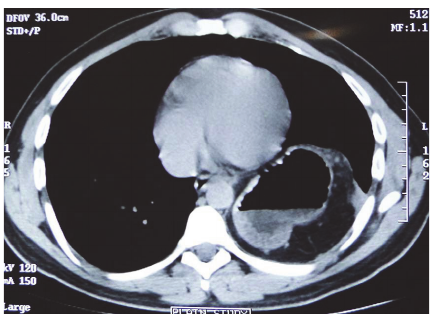
Figure 2: Composite mesh fixed with tackers.